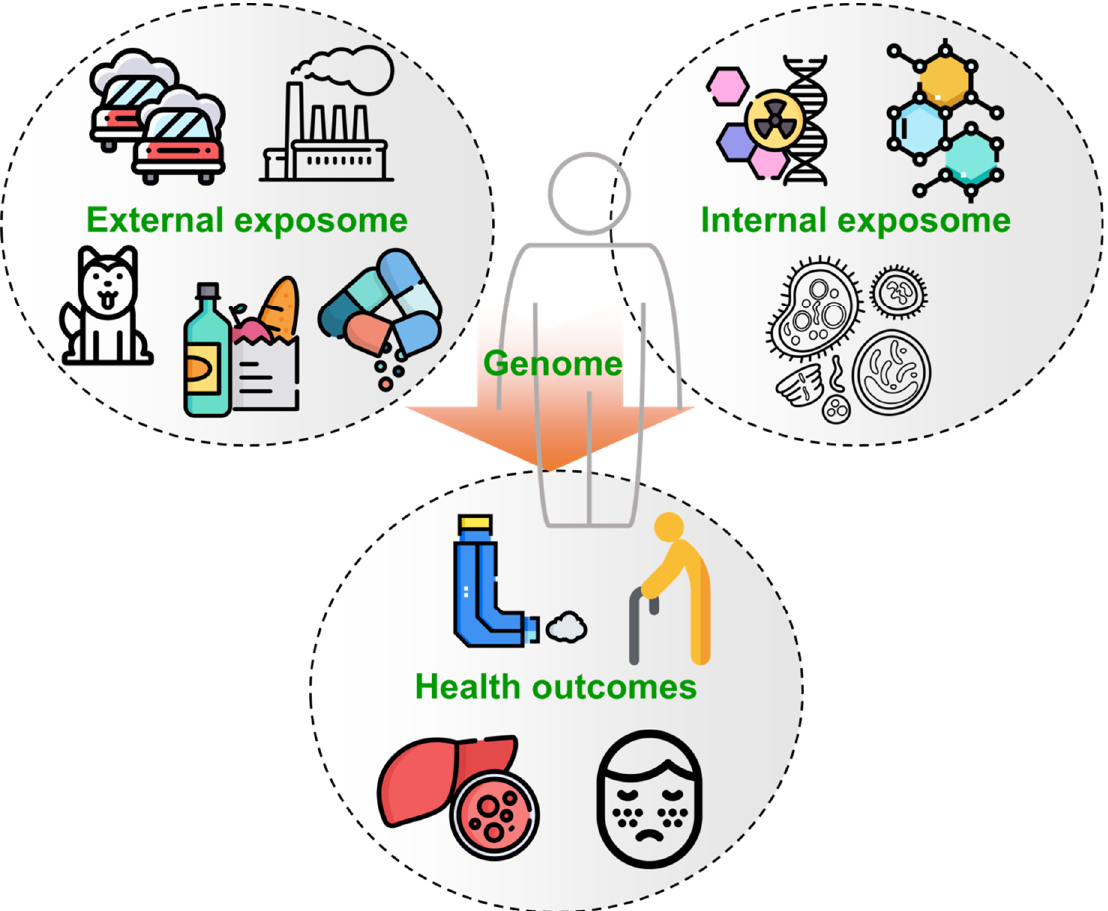
Figure 1. The concept of the exposome. The human exposome is often divided into the external exposome (e.g., air, diet, and social factors) and internal exposome (biological responses to exposure). Interactions between exposure and genetic factors can lead to disease or adverse health outcomes (e.g., aging, allergy, asthma, and cancer). Icons are designed by Freepik. 2. What is the Exposome?